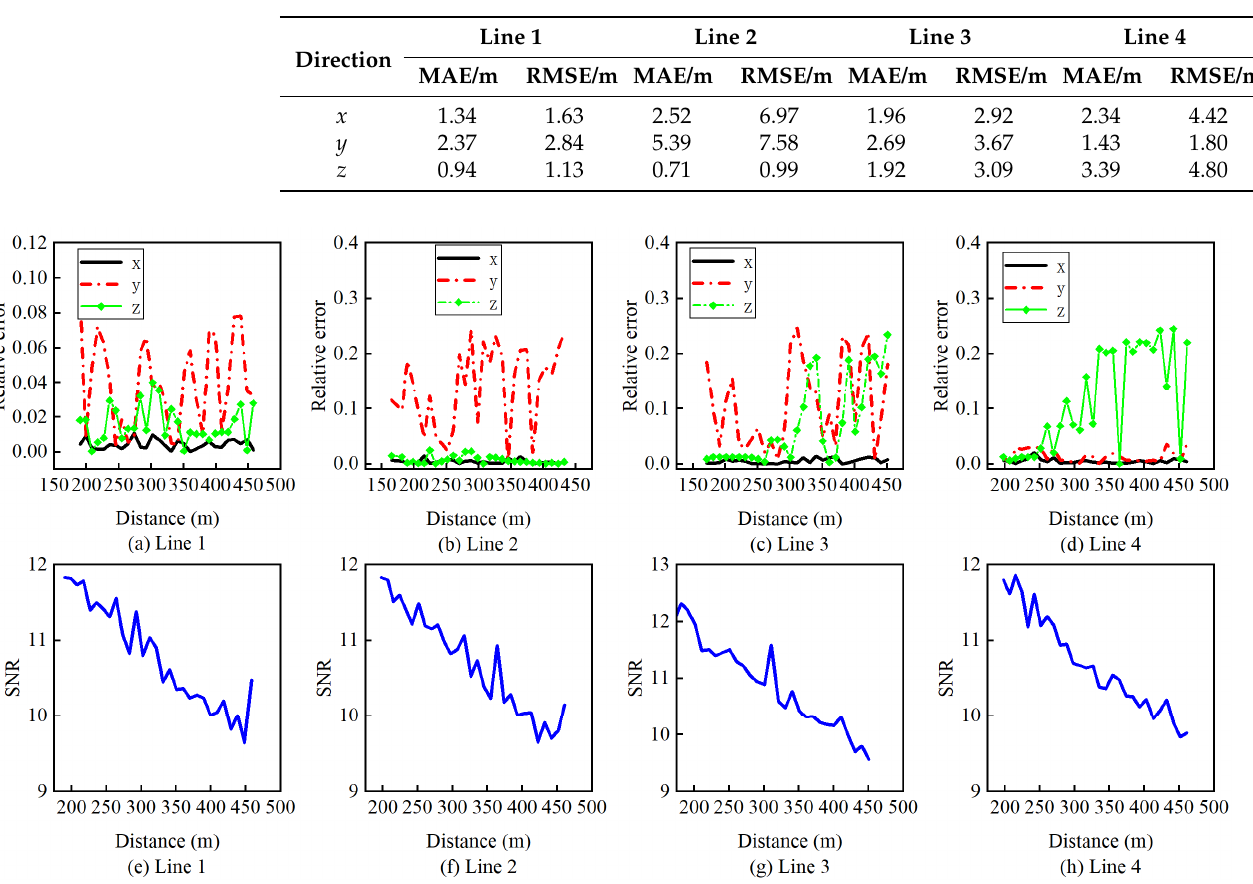
Table 3. Results of obstacle’s location.